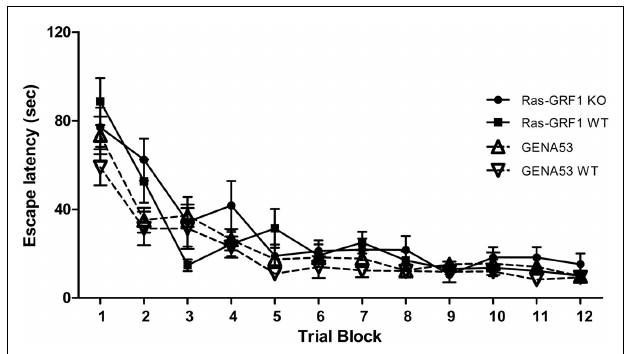
FIGURE 1 | Spatial learning in the Morris water maze. Escape latencies (mean ± SEM) during the 4 days of training are illustrated (results are shown by couples of trials). Ras-GRF1WT ( n = 12); Ras-GRF1 KO ( n = 12); GENA53WT ( n = 12); GENA53 ( n =